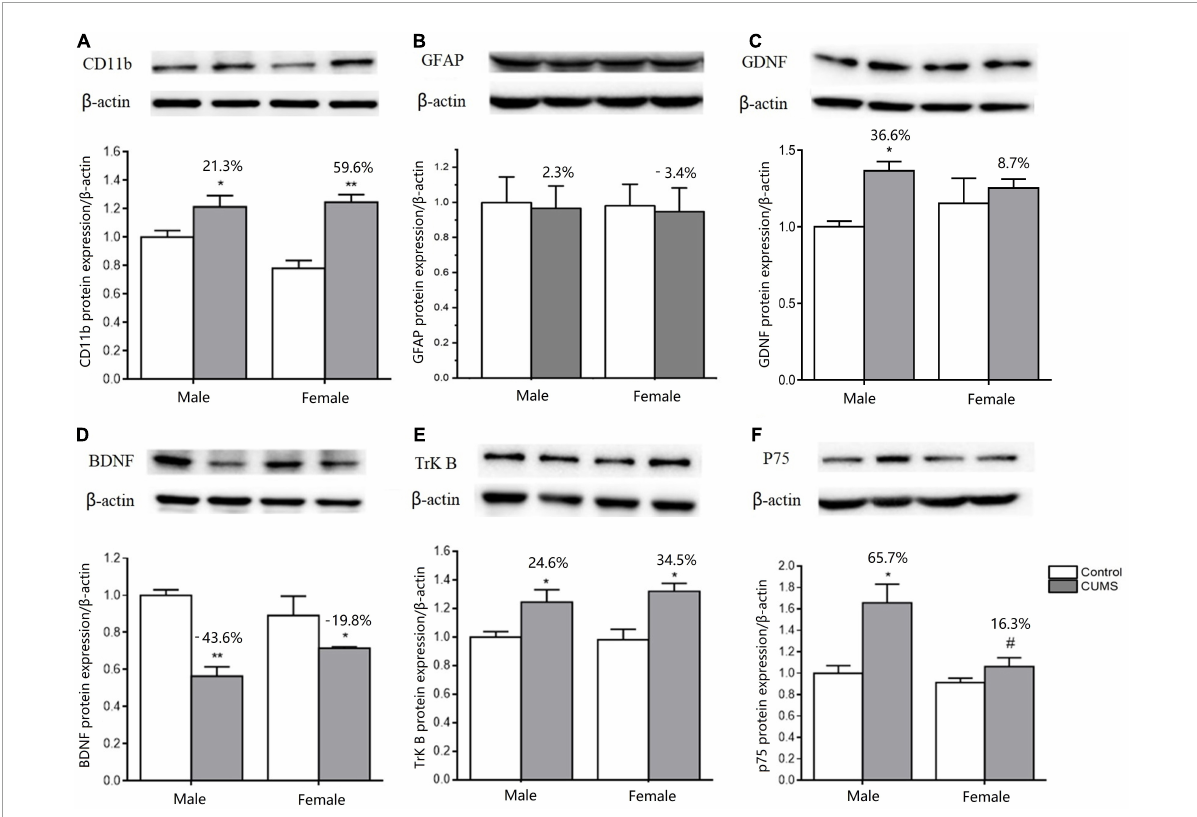
FIGURE11 CUMS influenced the microglial and astroglial marker protein expressions in the hippocampus of male and female rats. (A–F) WB analysis of microglial and astroglial marker protein expression of CD11b, GFAP, GDNF, BDNF, TrK B, and p75. * p < 0.05, ** p < 0.01 vs. control with same sex. # p < 0.05 vs. male stress